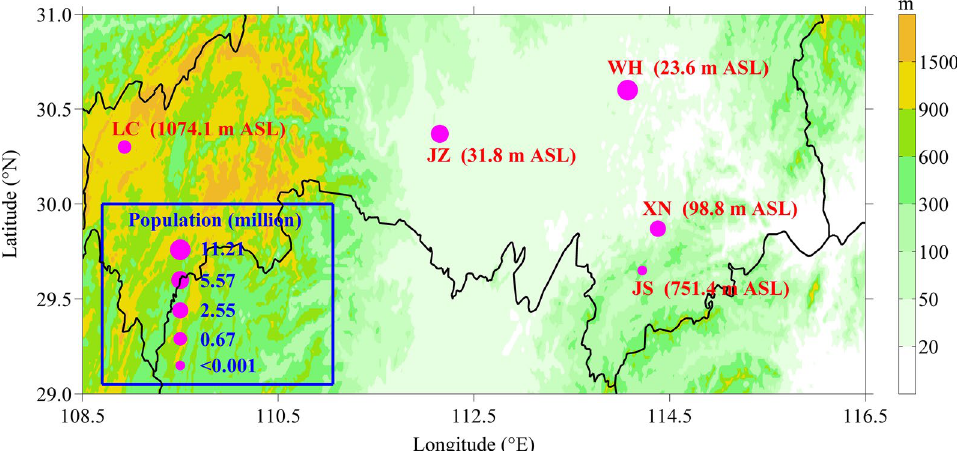
Figure 1. Geographic location of Wuhan (WH), Jingzhou (JZ), Xianning (XN), Lichuan (LC) and Jingsha (JS) stations in central China and their population in 2019. This map is generated with the MATLAB